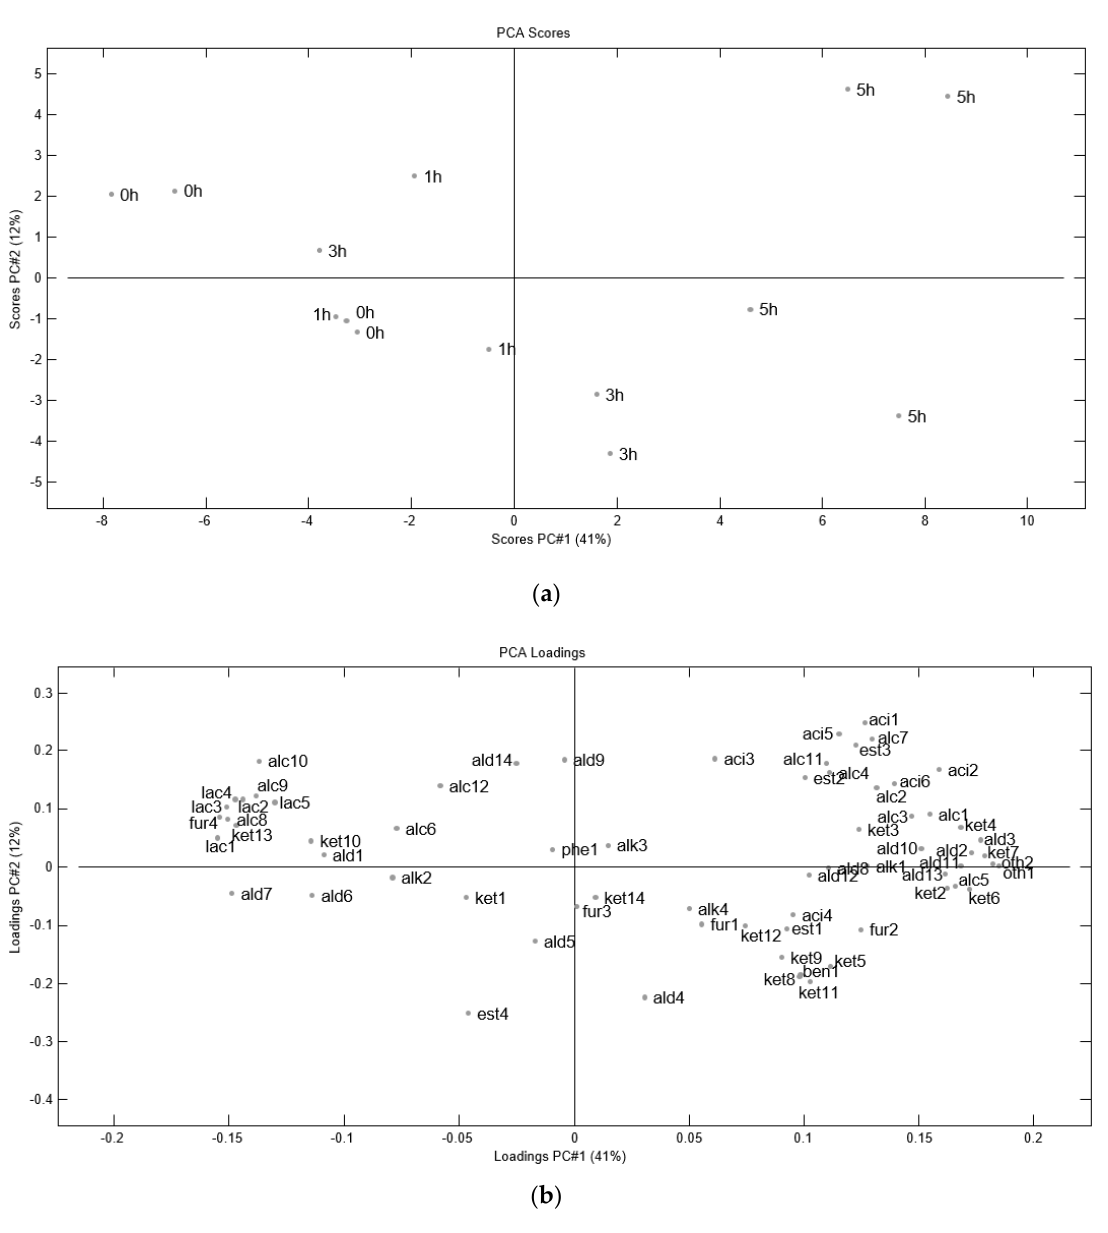
Figure 1. ( a ) Principal Component Analysis (PCA) score plot (minus outliers) for the effect of time on enzymatic hydrolysis of porcine hemoglobin with papain; ( b ) PCA loading plot showing the occurrence of volatile compounds during hydrolysis. Codes are equivalent to those found in Table 2.